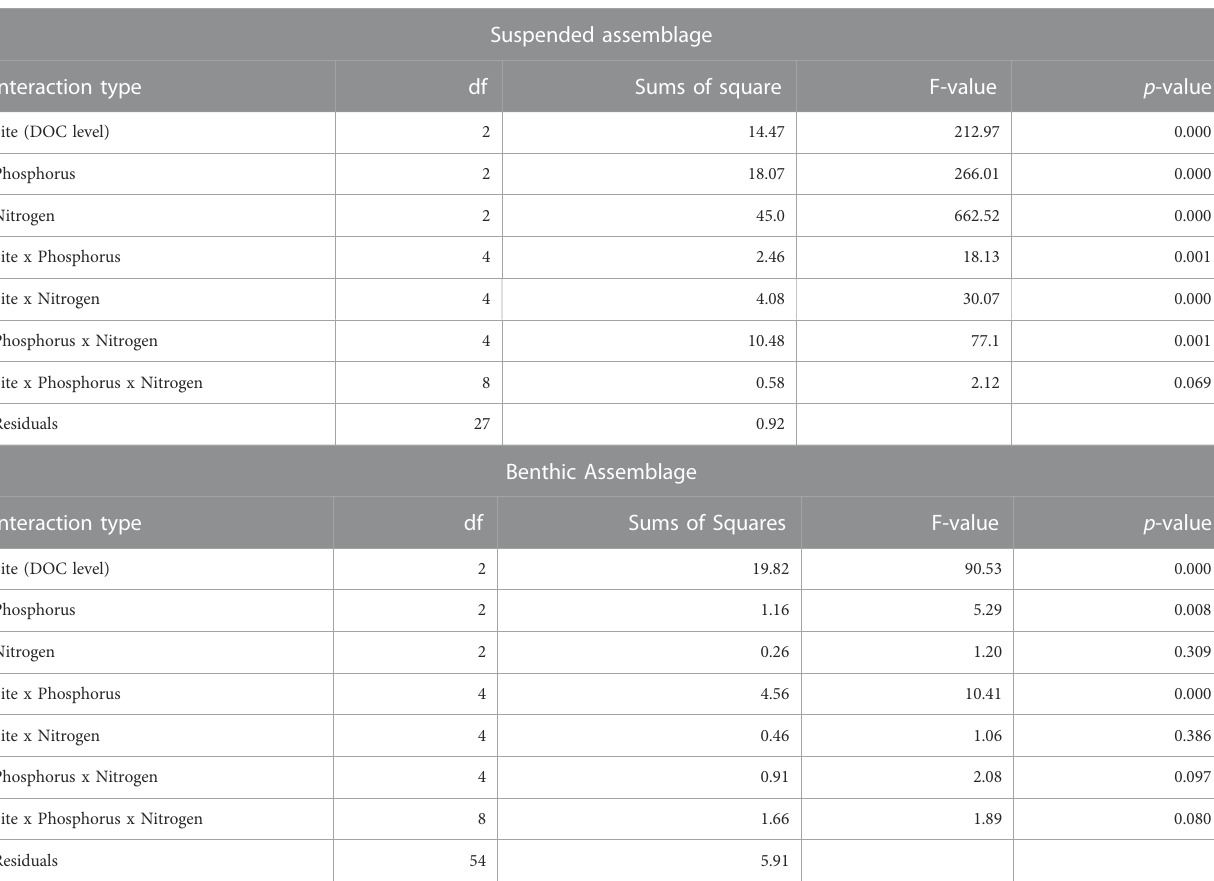
TABLE3Resultsfrom3-wayANOVAevaluatingtheeffectsfactorialnutrientenrichmenthadonbothsuspendedandbenthicalgalbiomass(aschlorophyll)among three stream sites of varying DOC concentration. Suspended